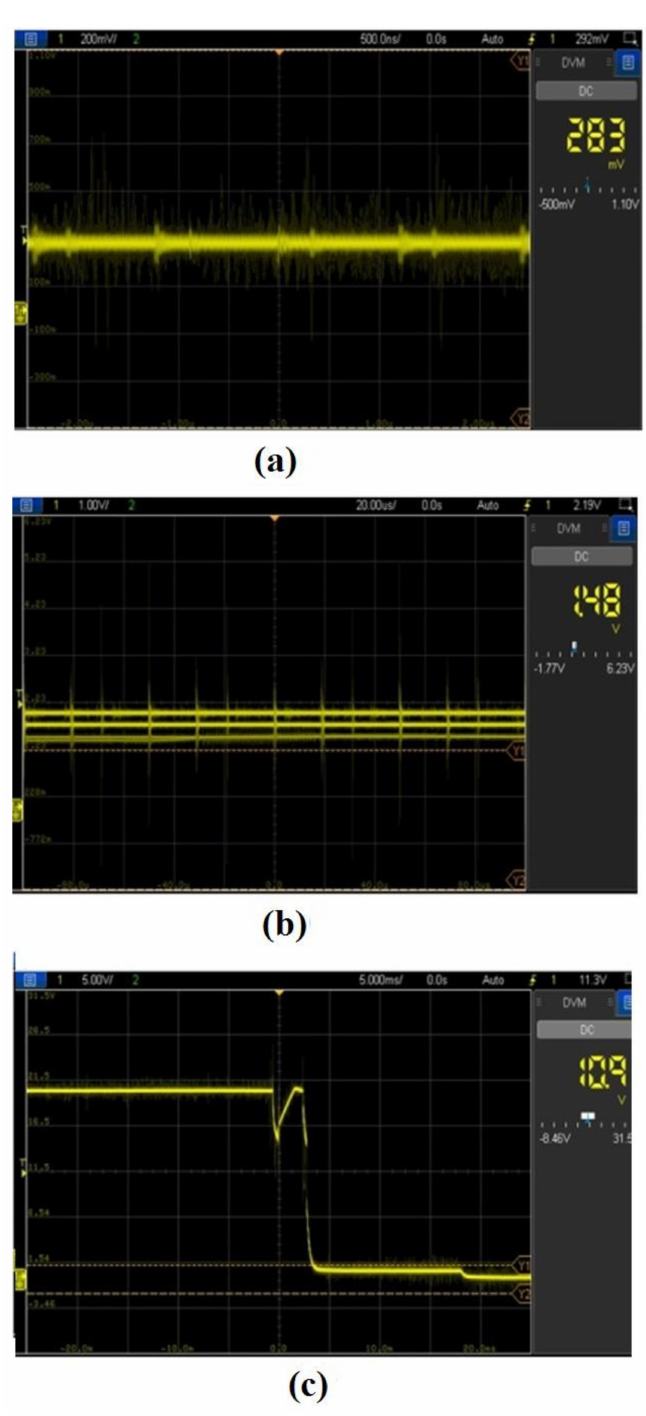
Figure 6. Pulse from analysis during ( a ) short circuit, ( b ) arcing, and ( c )